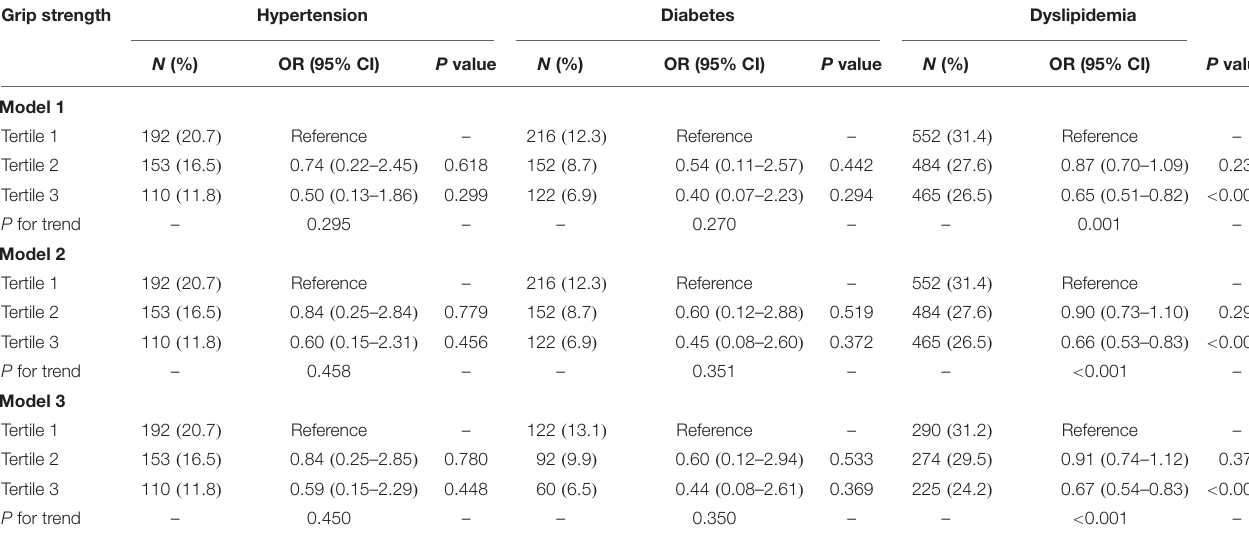
TABLE 3 | The associations between relative handgrip strength and cardiometabolic disorders in females. Grip